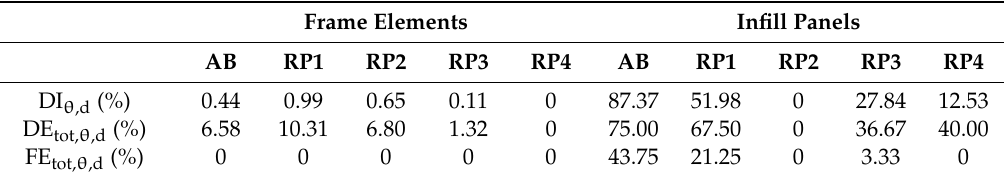
Table 7. DI, DE tot , and FE tot for AB and RPs configurations. Frame